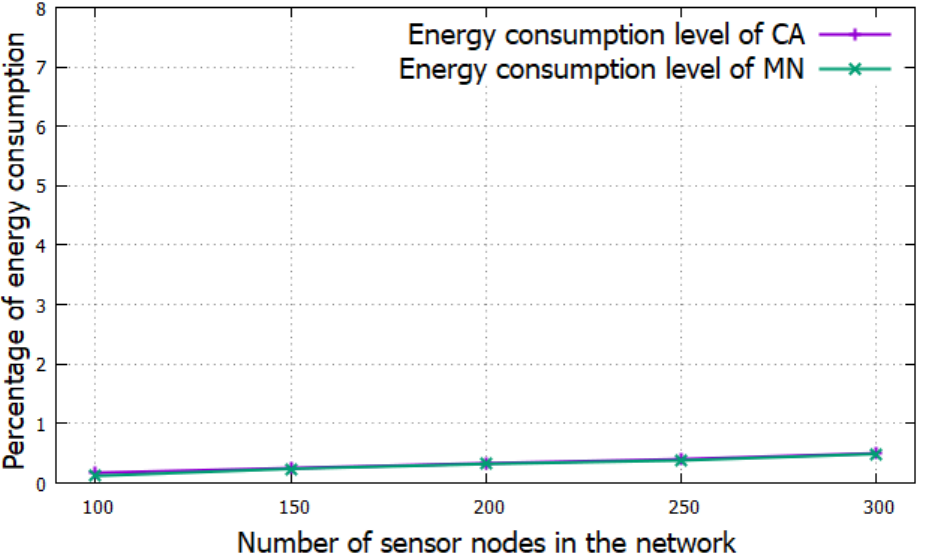
Figure 7. The percentage of energy consumption as a function of the number of sensor nodes in the network.